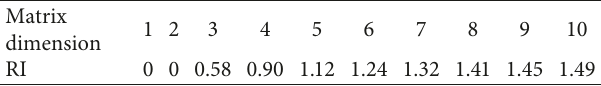
Table 3: The random consistency index RI under different dimensions.